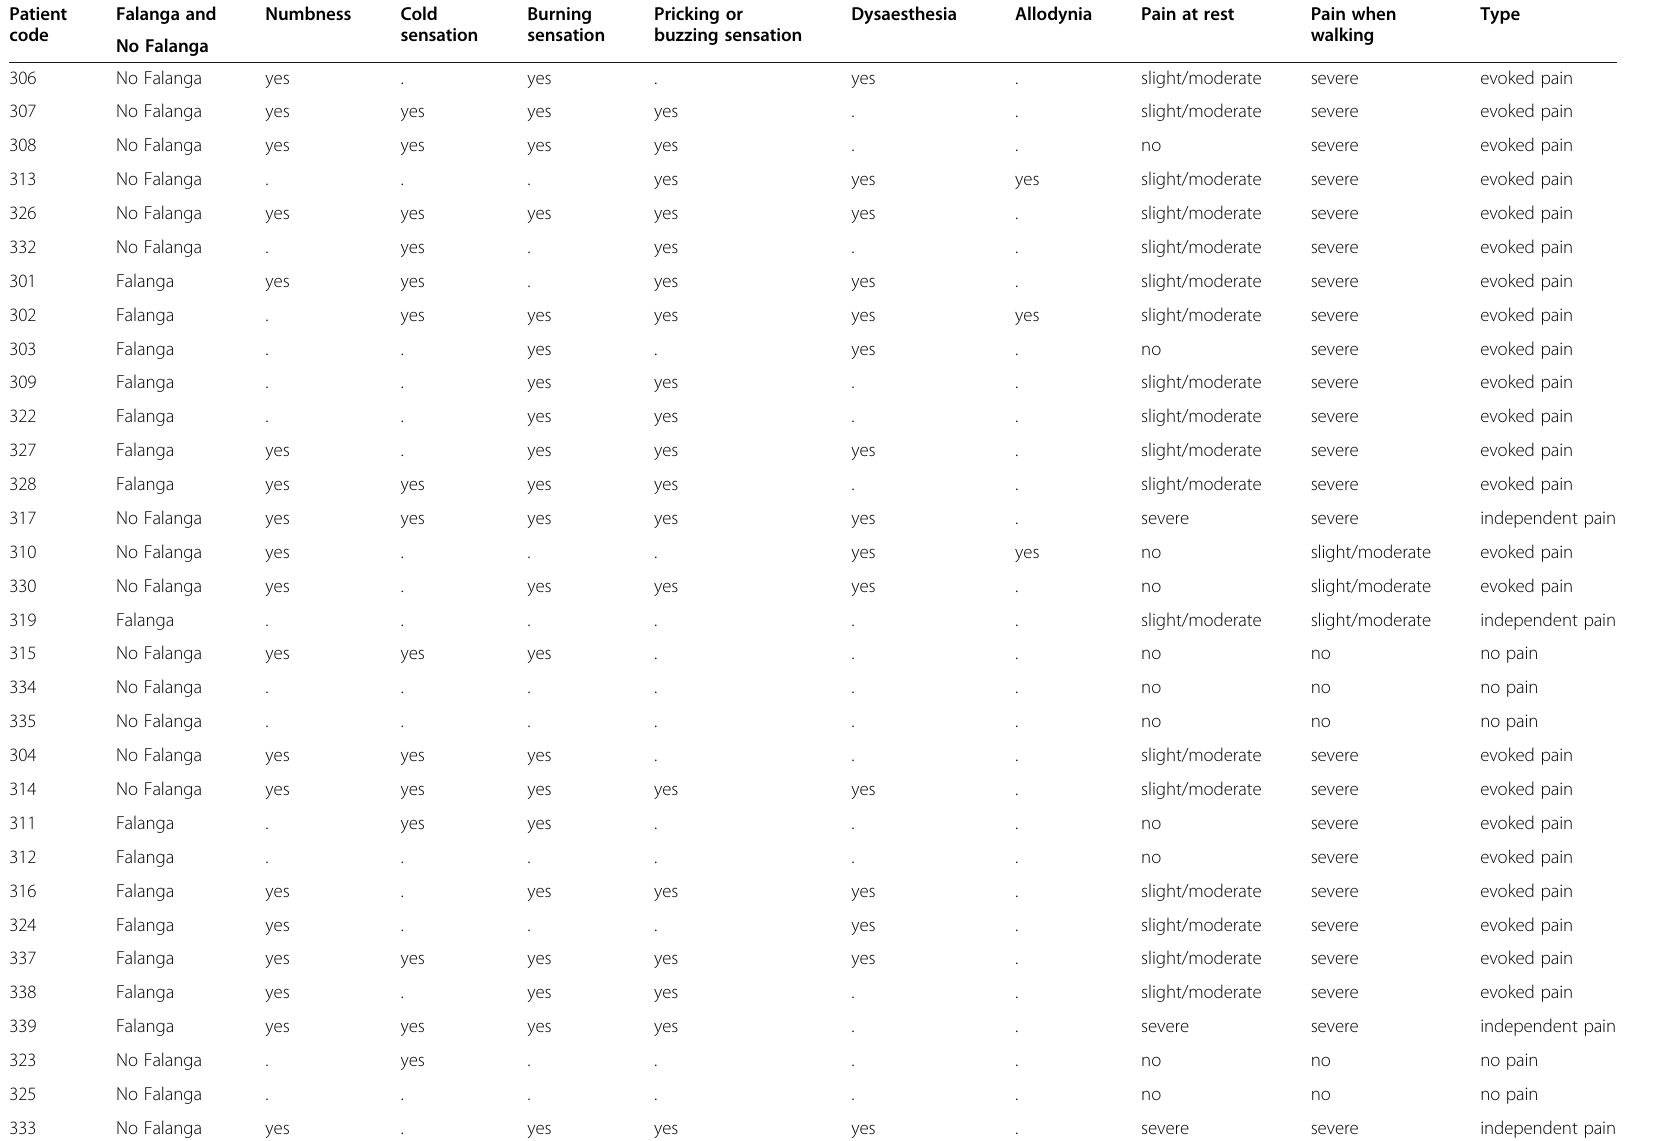
Table 3 Reported pain, sensory symptoms, pain at rest, pain when walking and type of foot pain sorted by ‘ PPT, pain when walking and type of foot pain ’ in the left foot sole of 32 torture victims (blank space=normal) (see Table 4) Patient Falanga and code